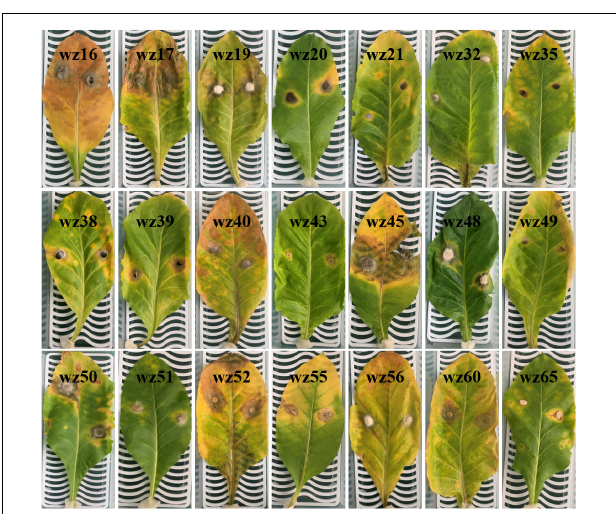
FIGURE 8 | Symptoms on inoculated tobacco leaves at 10 days after inoculation and incubation at 28 ◦ C. These isolates came from symptomatic leaves and their identification based on ITS sequences is shown in Table 4 . The white mesh board behind each leaf is the same size (25 cm × 10